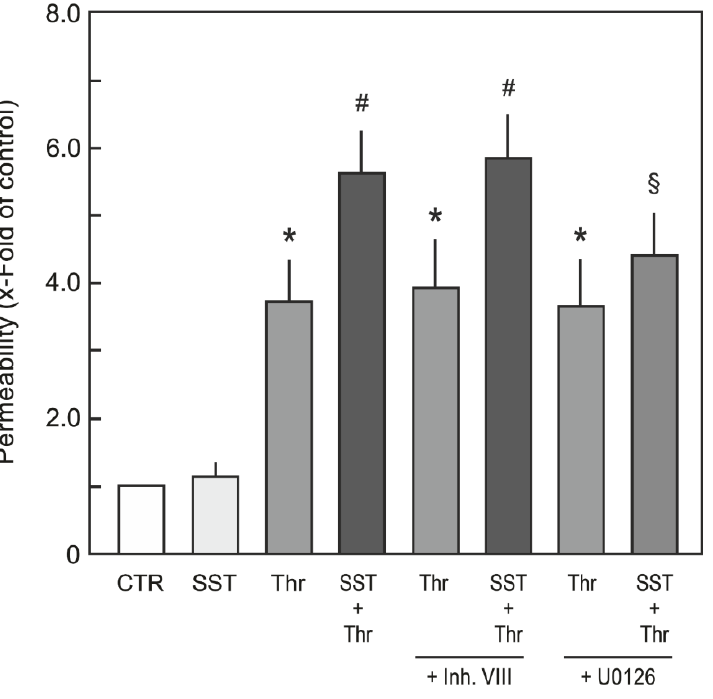
Figure 3. Effect of inhibitors of Akt and MEK/ERK pathways on SST14-mediated HUVEC sensi- tisation . HUVEC monolayers cultured on filter membranes were treated with SST14 (1 nM) or buffer (CTR) followed by treatment with thrombin (Thr; 0.5 U /mL). In the sets of experiments where Akt and MEK/ERK inhibitors were used, these were added 30 min before adding SST14 or buffer. Flux of albumin across HUVEC monolayers 10 min (maximum effect) after Thr treatment is presented. n = 3; p<0.05; * vs. control, # vs. Thr alone, § vs. SST+Thr.